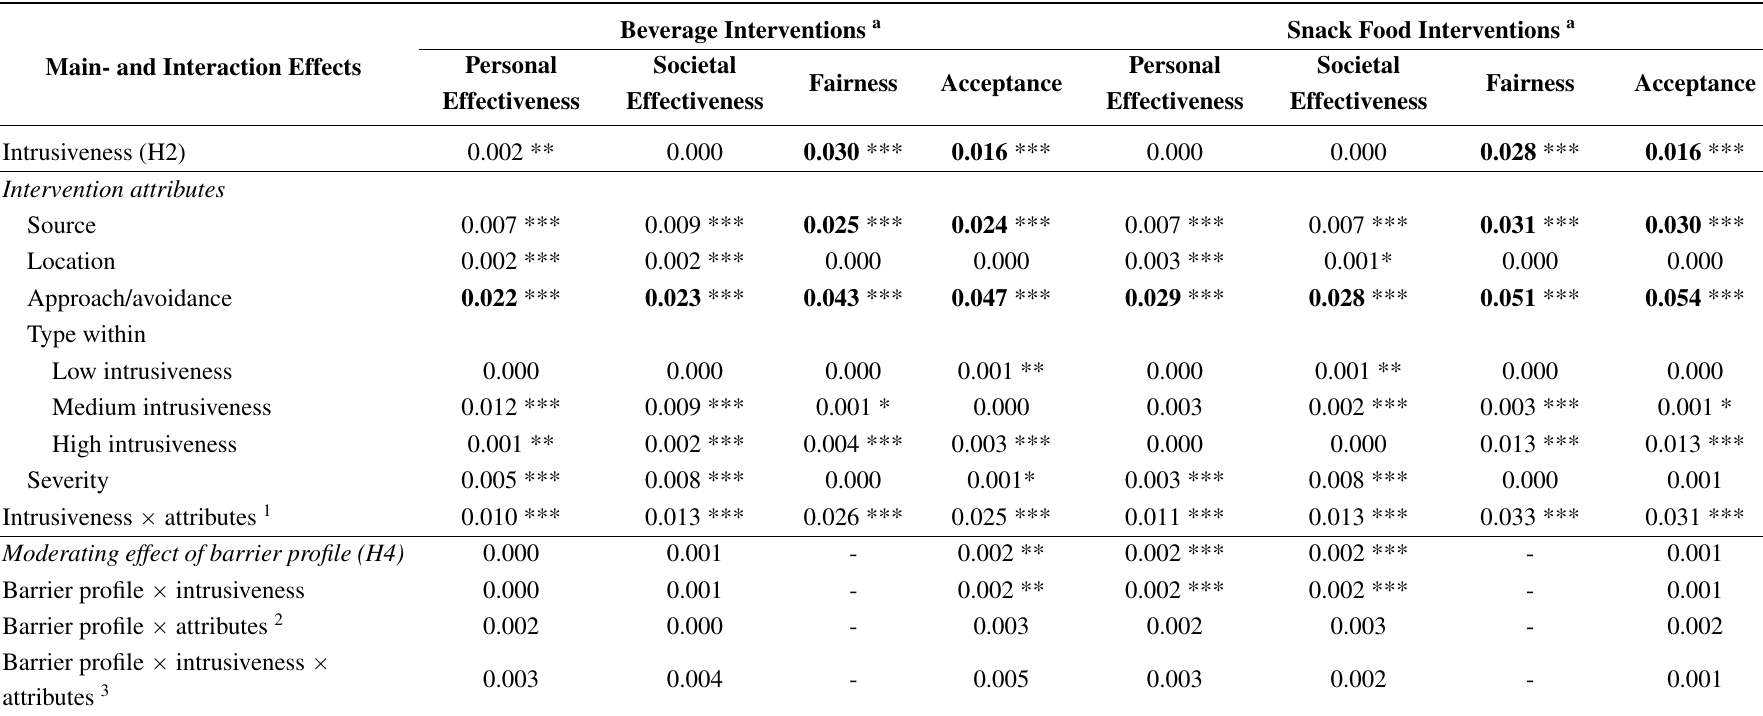
Table 4. Effect sizes (partial η 2 ) of intrusiveness, intervention attributes, barrier profile, and responsibility on evaluations of interventions.